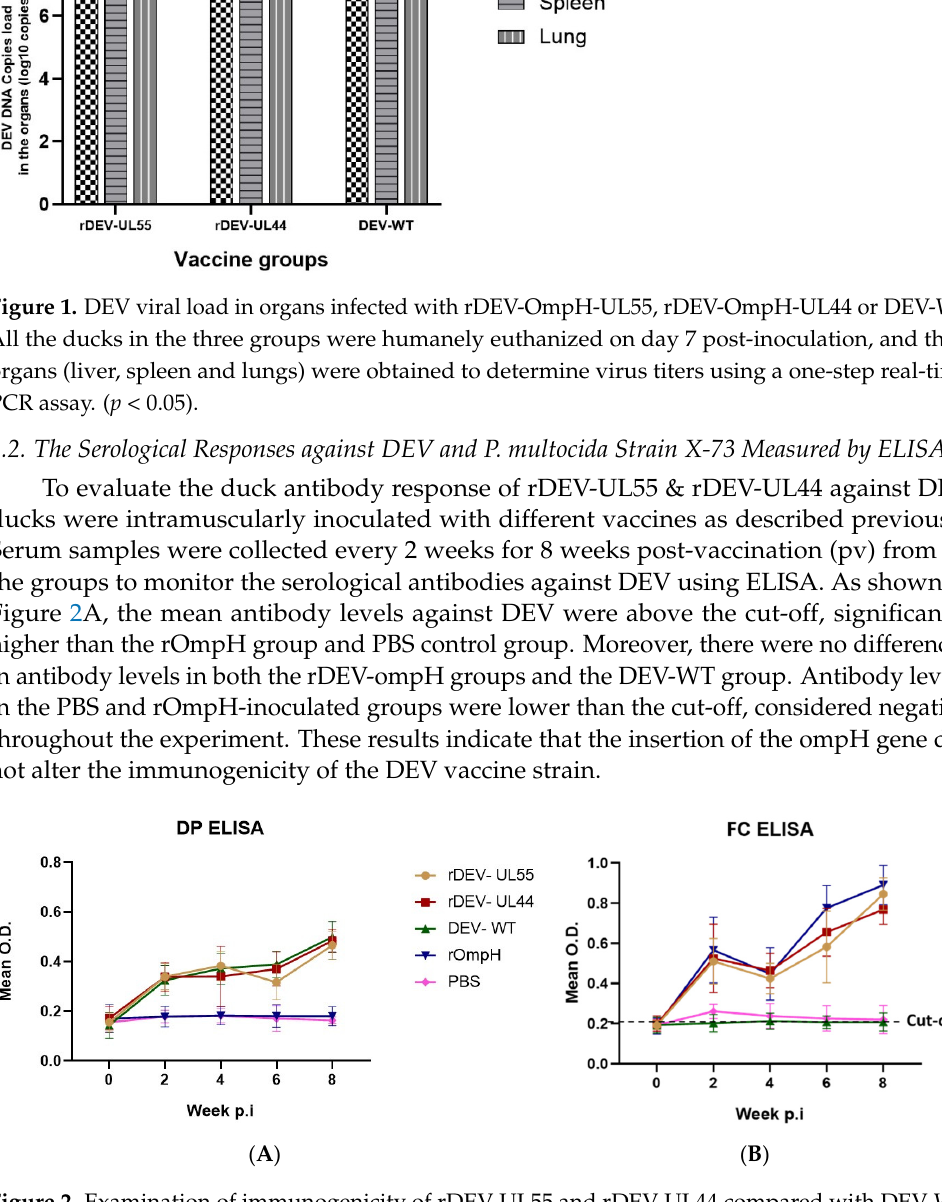
Figure 2. Examination of immunogenicity of rDEV ‐ UL55 and rDEV ‐ UL44 compared with DEV ‐ WT, rOmpH and PBS post ‐ immunization in ducks against DEV ( A ) and P. multocida X ‐ 73 ( B ) using